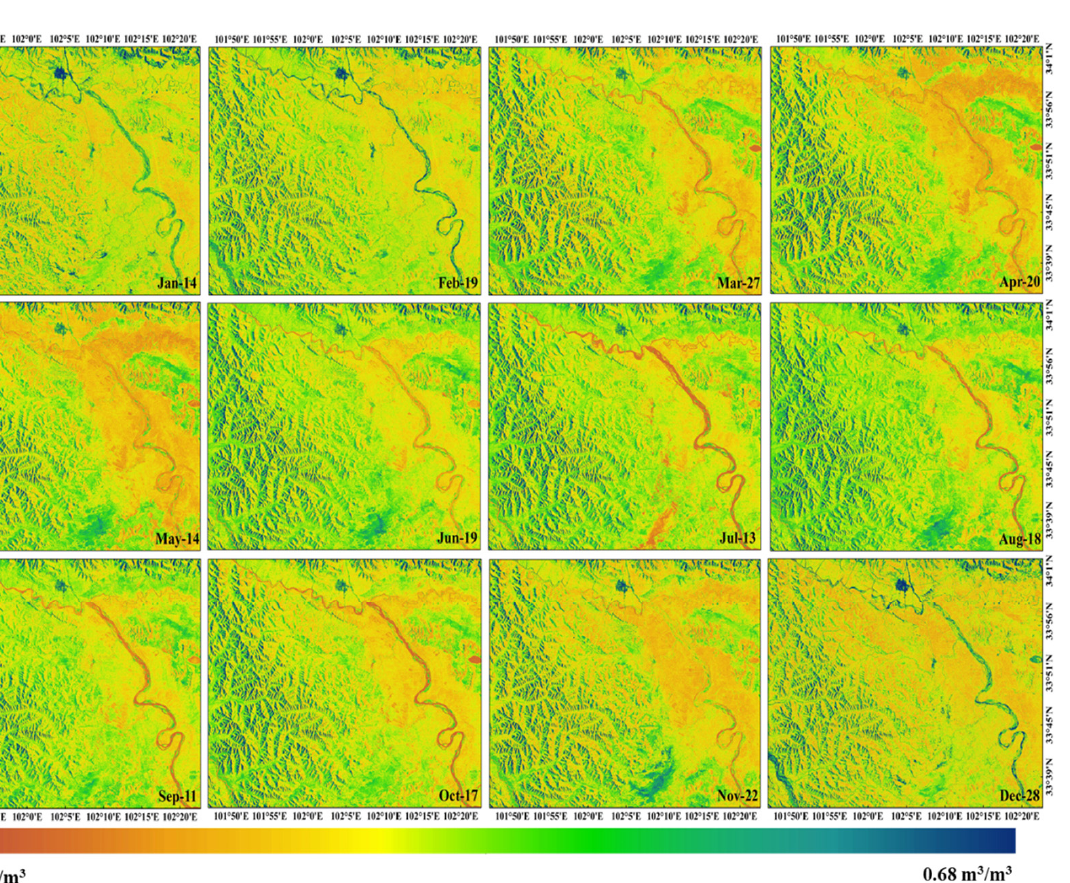
Figure 11. Soil moisture with RF for descending orbit of Maqu network for 2018.